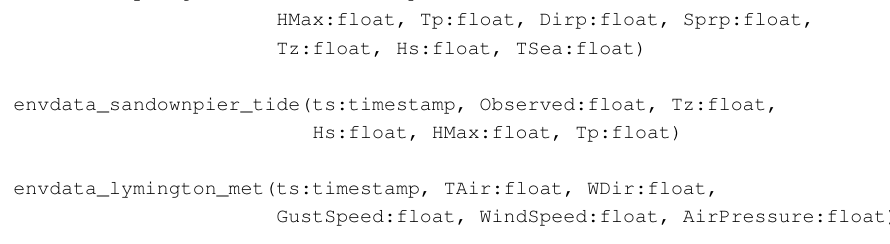
Figure 5. Example schema of the streams generated by the Channel Coastal Observatory wireless sensor network deployment; published as a streaming data service ( CCO - WS